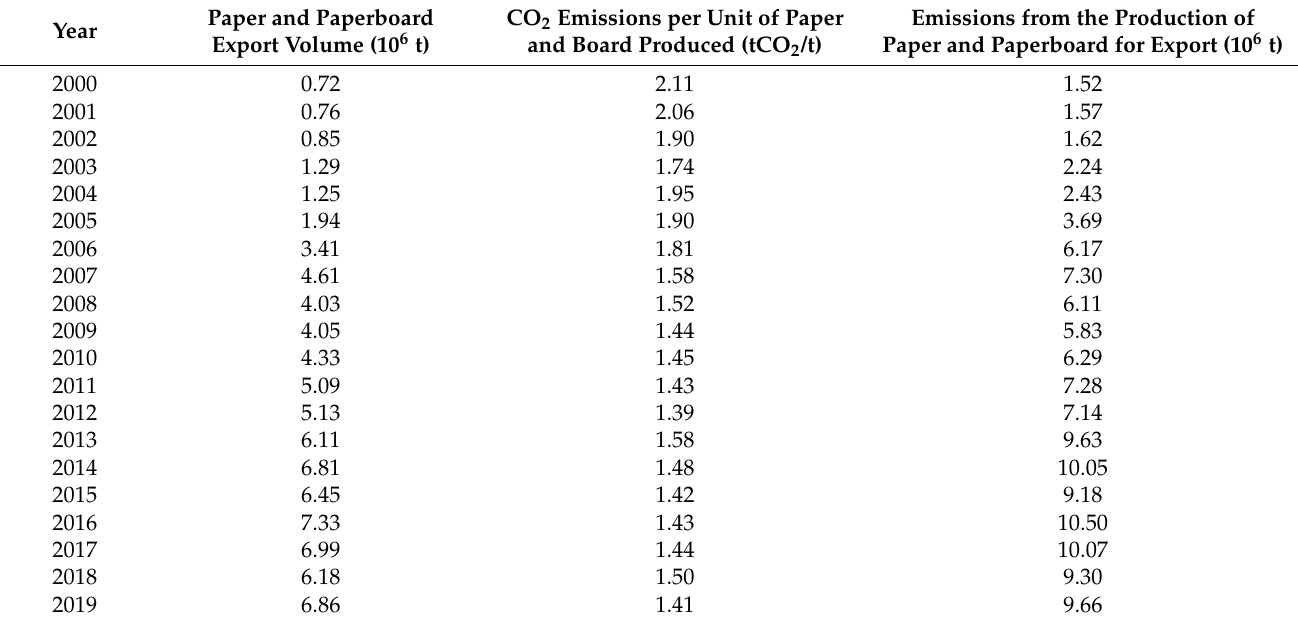
Table 3. CO 2 emissions from exported paper and board.